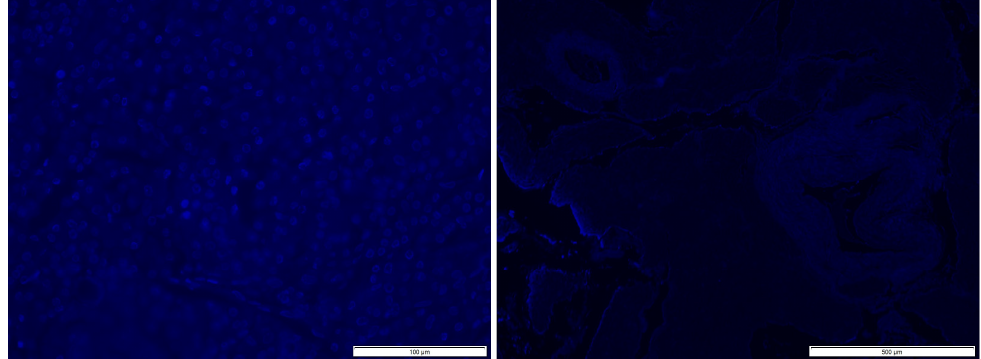
Figure 2. Microscopic image of DAPI staining of native tissue (( a ); scale: 100 µm) and decellularized tissue (( b ); scale: 500 µm).